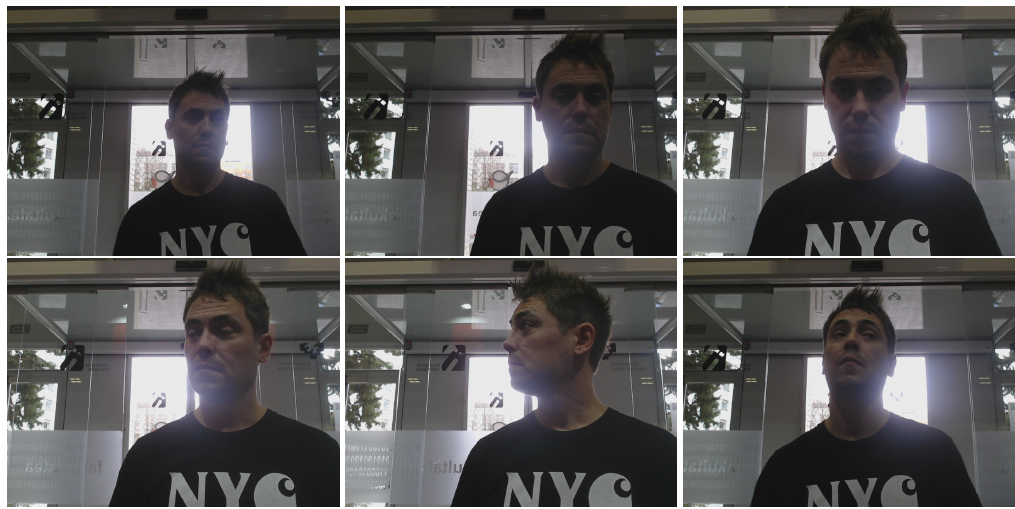
Figure 5. Some instances of the capturing process. The spot corresponds to the main entry of the Faculty, where the lighting conditions are